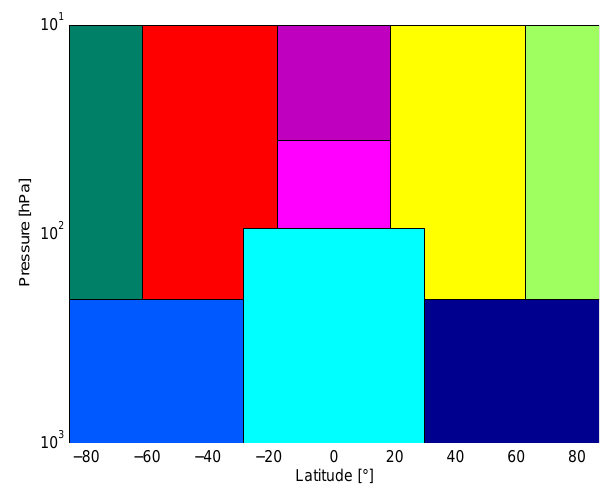
Fig. 2. Defined regions of the ozone origin diagnostic with each